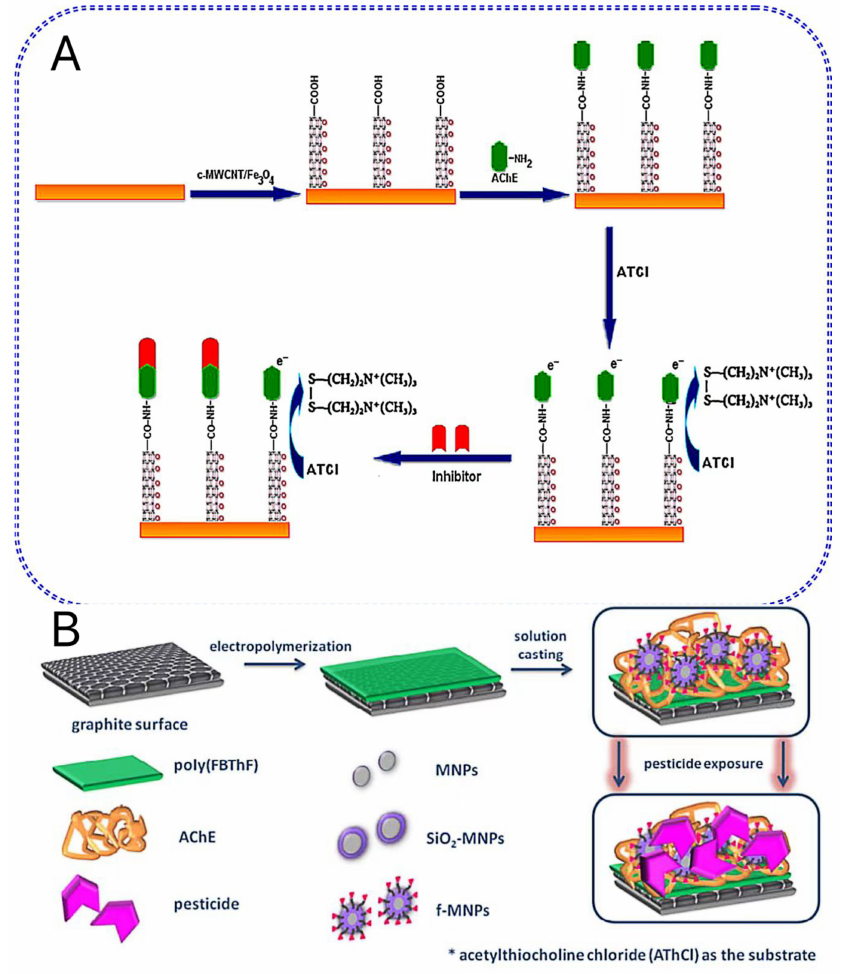
Figure 1. Schematic illustration of the stepwise amperometric biosensor fabrication process and immobilized acetylcholinesterase inhibition in pesticide solution ( A ). Reproduced with permission from Chauhan and Pundir [52] Anal. Chim.Acta; published by the Elsevier B.V., 2011. Schematic representation of the biosensor ( B ). Reproduced with permission from Dzudzevic Cancar et al. [55] ACS Appl. Mater Interfaces; published by the American Chemical Society